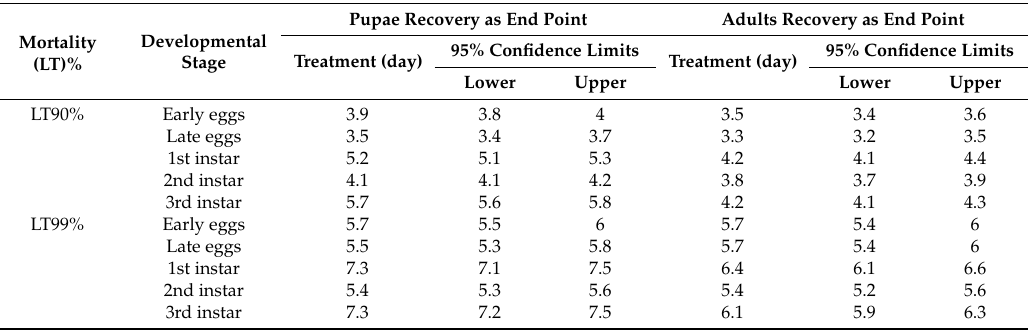
Table 2. Cold treatment duration to induce 90 and 99% mortality based on pupation and emerged adults of five C. capitata developmental stages fed on lab diet. The models were selected based on the result in Table